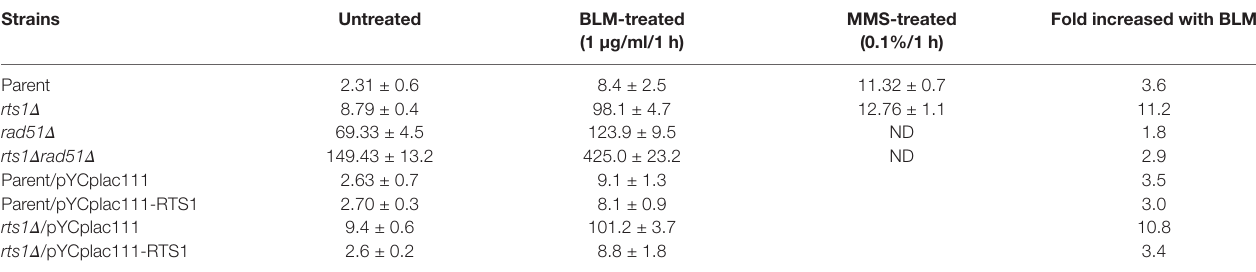
TABLe 1 | Frequency of spontaneous and induced Can R mutations (×10 −7